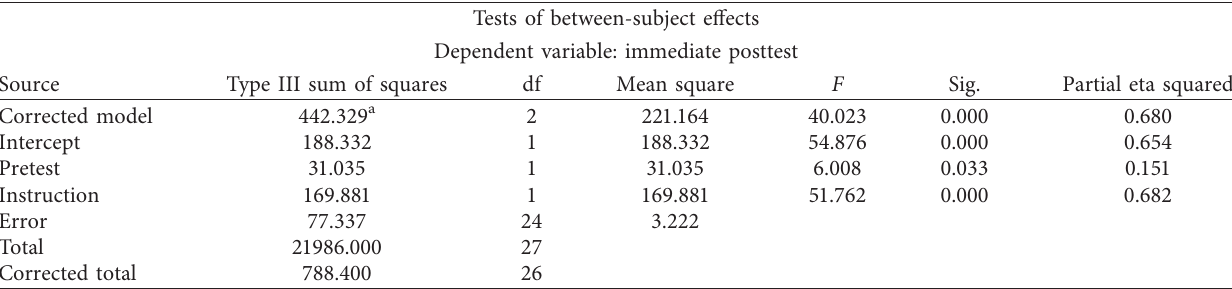
Table 3: Inferential statistic for comparing the online peer feedback and non-peer-feedback.